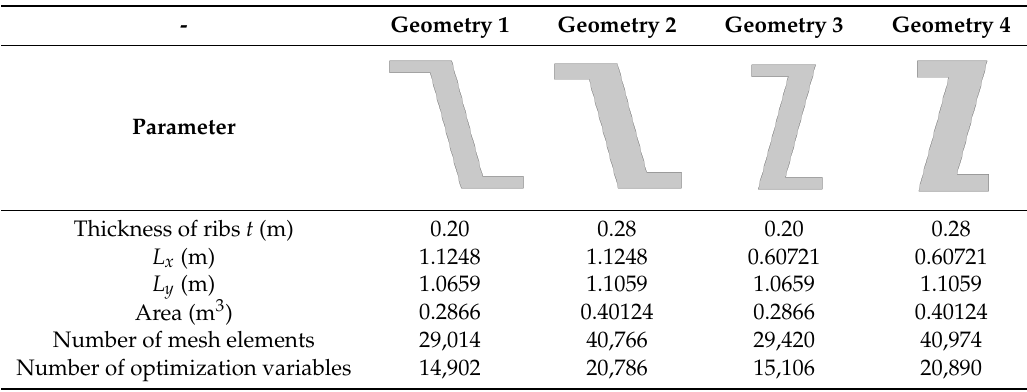
Thickness of ribs t